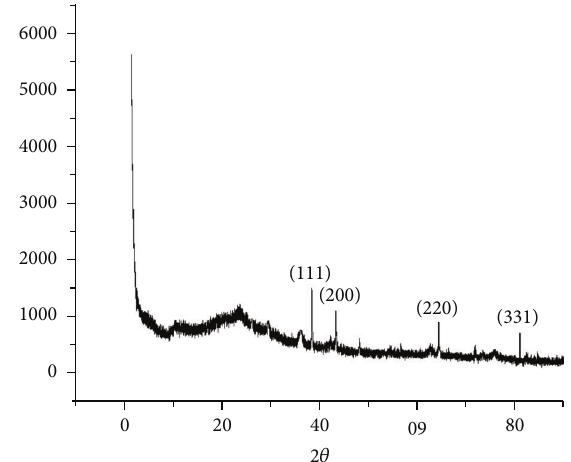
Figure 3: XRD pattern of synthesized silver nanoparticles.